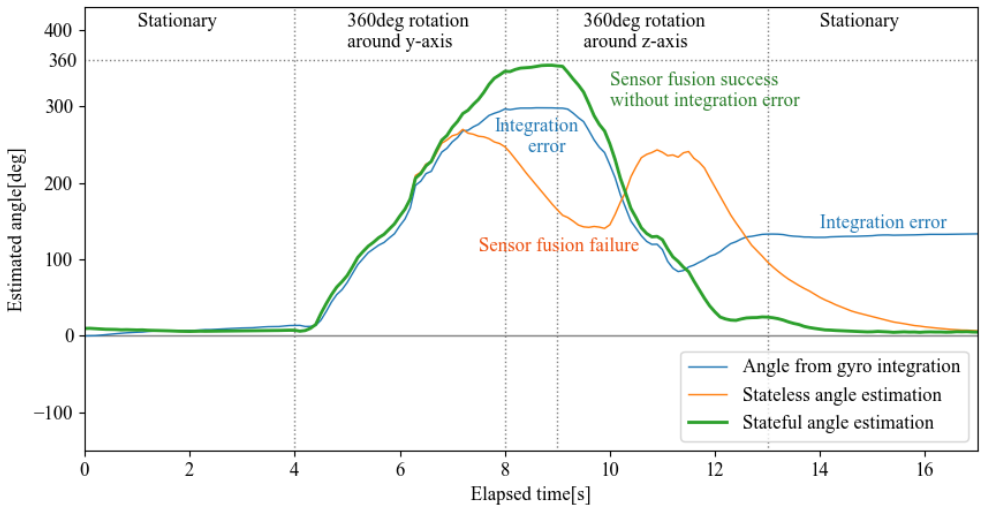
Figure 13. Fast angle estimation for stateful